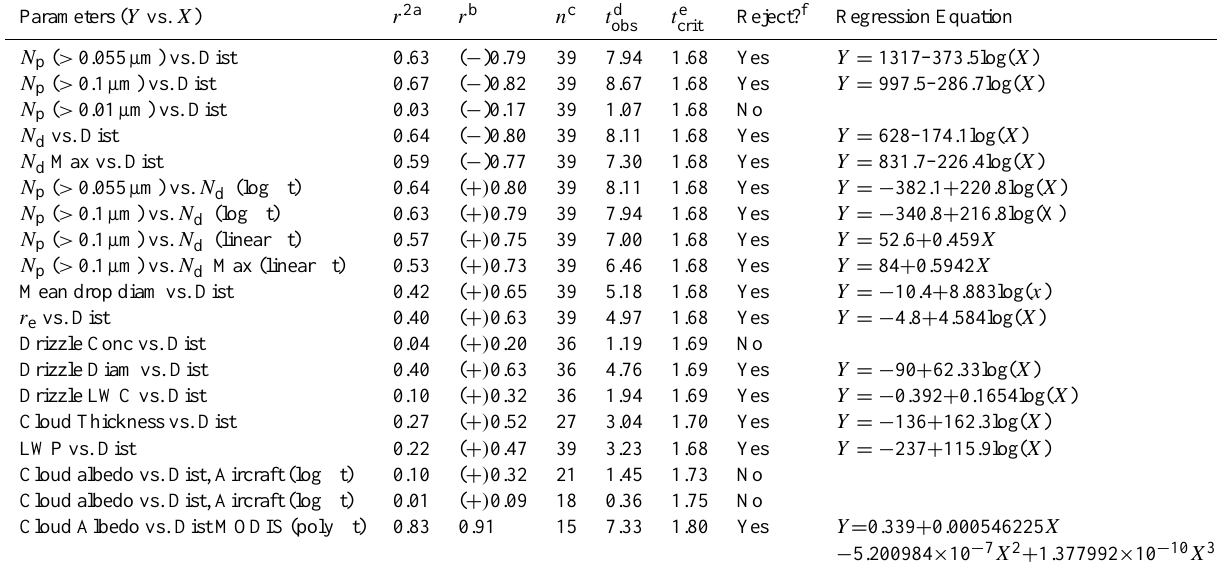
Table 2. Significance of Fitted Relationships between Various Parameters. Parameters ( Y vs. X ) r 2a r b